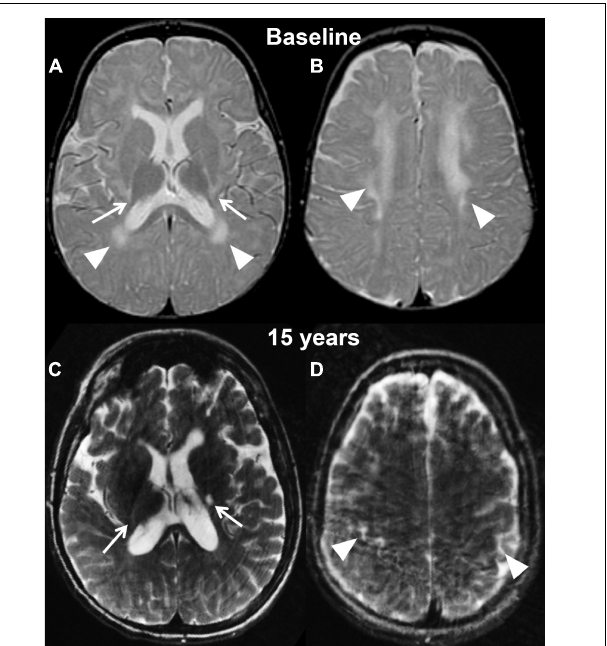
FIGURE 2 | Axial T2 weighted images at baseline (A,B) and at the last follow-up evaluation (C,D) of the untreated patient (case 1). Panels (A,C) are planes crossing through the basal ganglia, while panels (B,D) are planes crossing through the corona radiata. The baseline study identifies capsular degeneration (arrows, A ) and periventricular white matter injury with “tigroid appearance” (arrowheads, B ) also known as the stripe sign. The tigroid appearance is also present in the white matter of the corona radiata (arrowheads, B ). The extra axial spaces are enlarged. The follow-up examination, which is represented in panels (C,D) , shows rapid and diffuse deterioration of the neuroimaging findings both at the level of the capsular regions (arrows, C ) and periventricular white matter (arrowheads, C,D ). The volume loss of the brain parenchyma is not accompanied by a significant increase in caliber of the extra axial spaces.